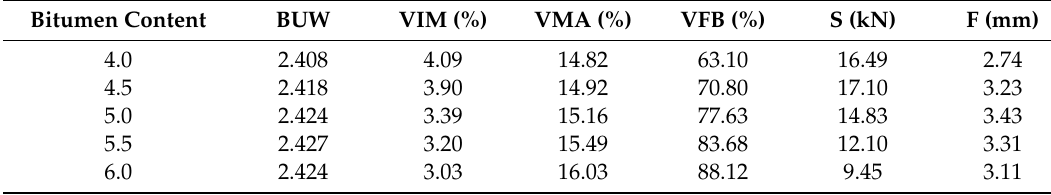
Table 2. Marshall properties of the virgin mix for